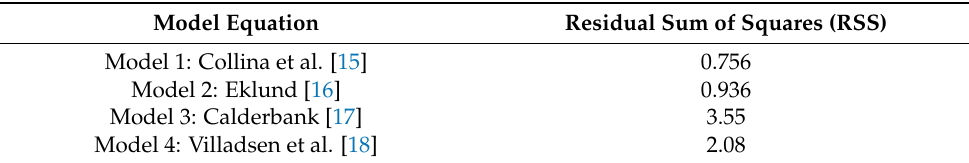
Figure 4. Residual sum squares (RSS) of each kinetic model for feed gas compositions of 10 mol% SO 2 , 11 mol% O 2 for ( a ) different temperatures at a constant pressure of 2.5 atm, and ( b ) different pressures at the constant temperature (400 °C). Table 2. Residual sum of squares for the four evaluated kinetic models over the entire range of the experimental